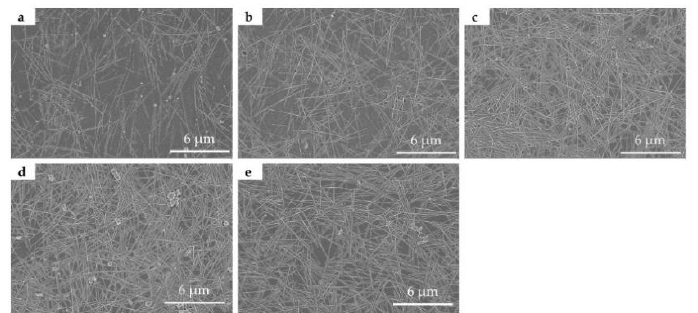
Figure 10. SEM images of the blue frame in Figure 8 from the printed patterns ( a ) to ( e ).